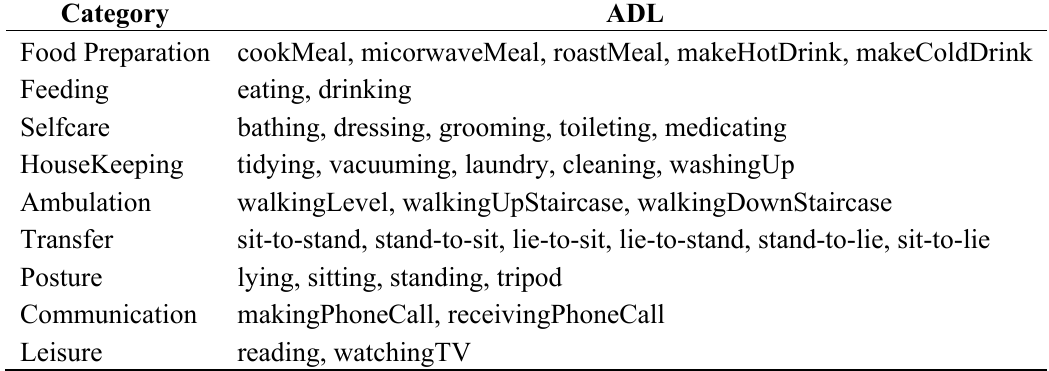
Table 1. Categories of